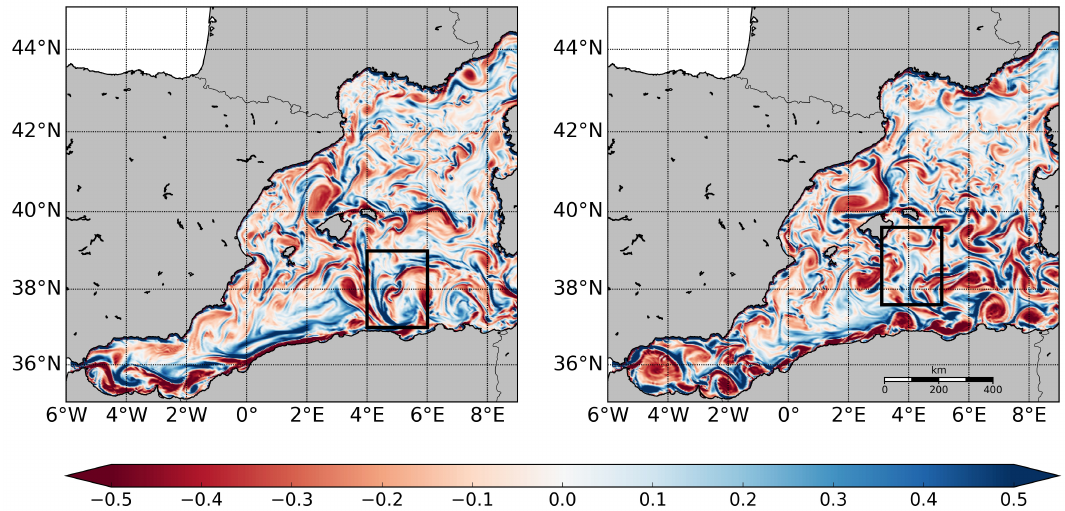
Figure 2. WMOP relative vorticity normalized by f on 23 January 2009 ( left ) and 3 February 2009 ( right ). Black boxes indicate the two regions studied in Section 3: box 1, pass 15 ( left ) and box 2, pass 168 ( right